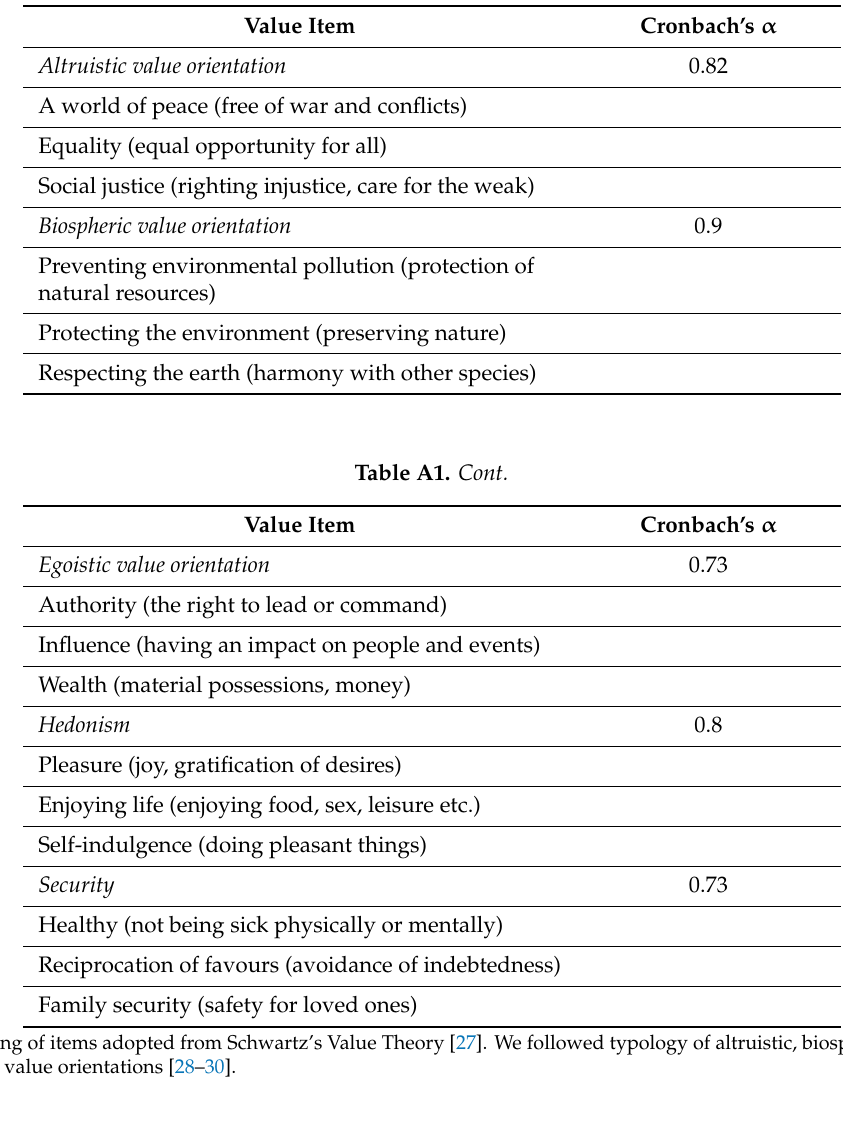
Table A1. Items to measure values and reliabilities of the value constructs (Cronbach’s α ) 1 .